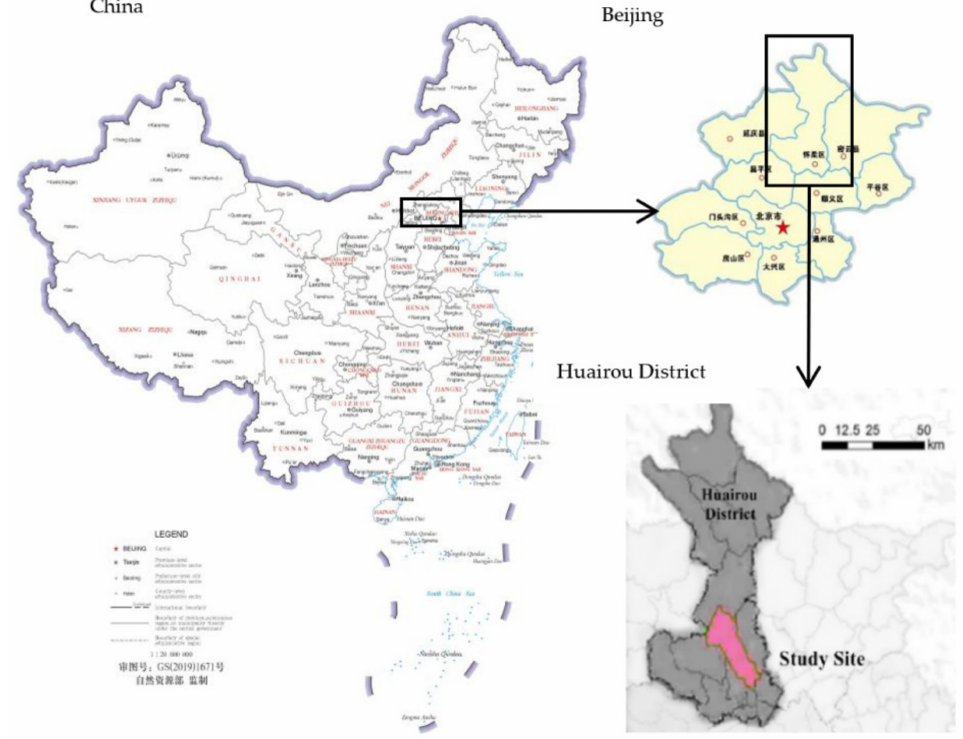
Figure 1. Location of Beitaishang state forest farm, Huairou District, Beijing,